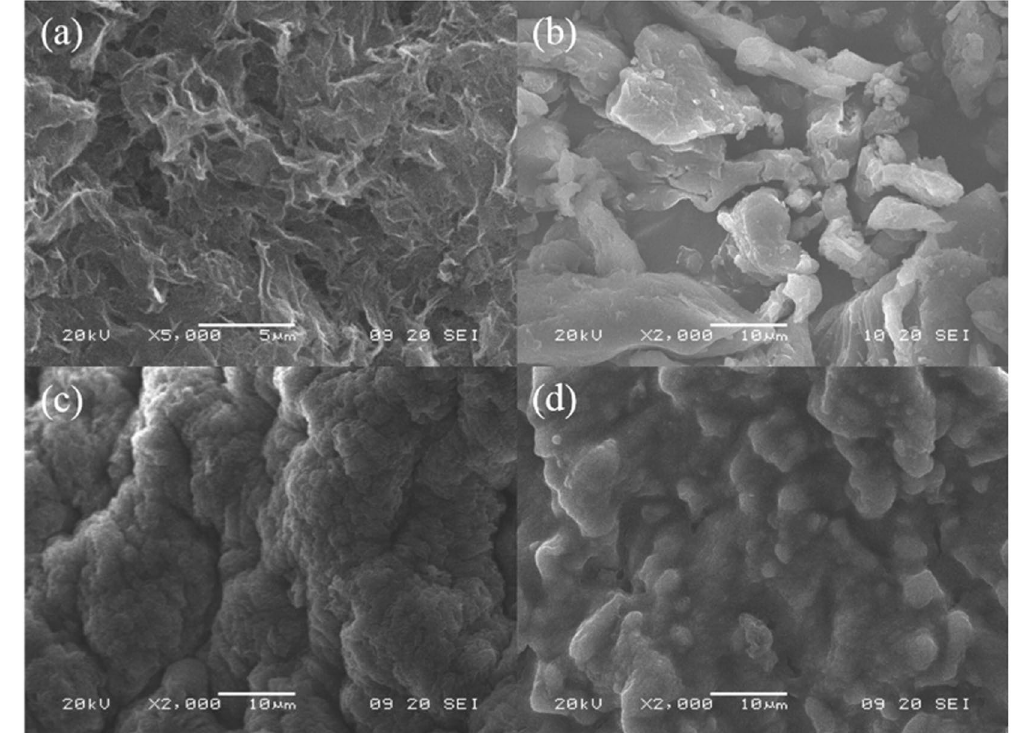
Figure 5. SEM of the ( a ) GO, the ( b ) sodium alginate, the ( c ) GAD before adsorption and the ( d ) GAD after adsorption.